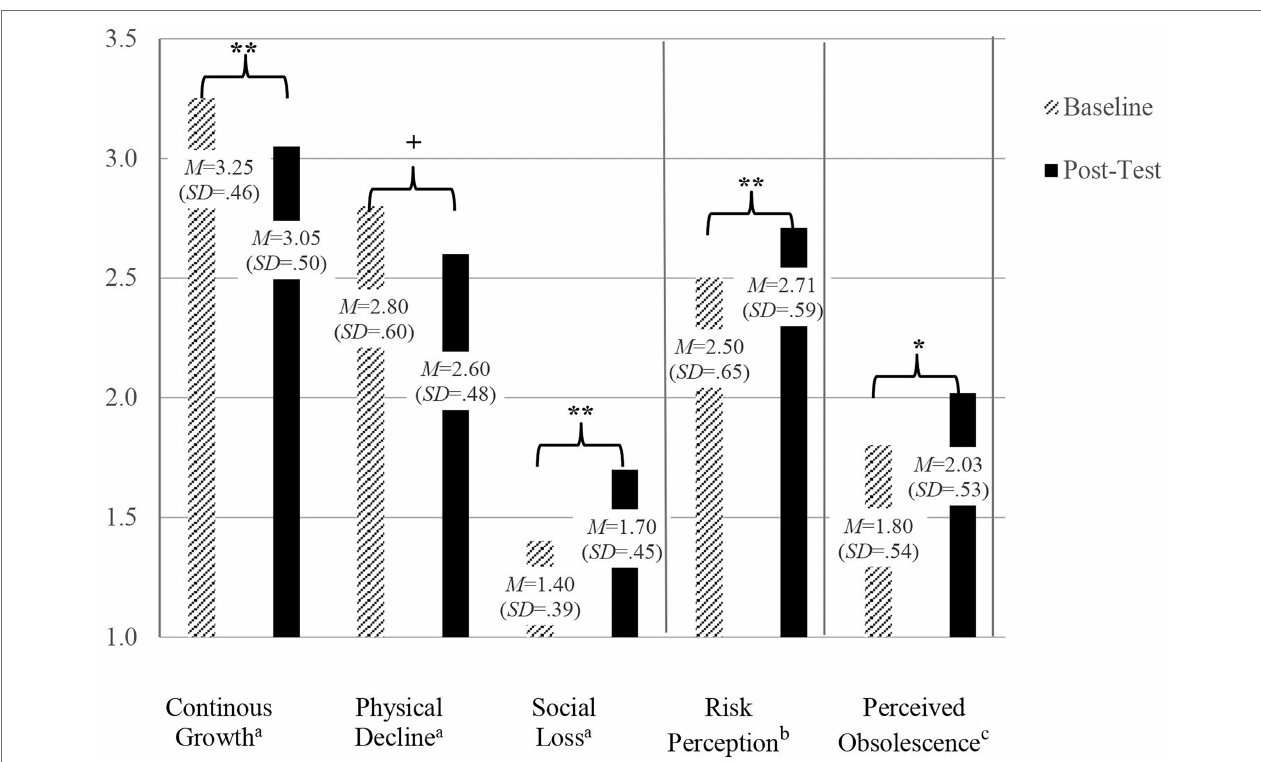
FIGURE 1 | Change in ageing-related cognitions, risk perception and obsolescence from baseline to post-assessment following the age simulation intervention. N = 40; a aging-related cognitions (AgeCog scale), 1–4, higher scores indicate stronger agreement; b 1–5, higher scores indicate higher perceived vulnerability in comparison to the same sex and age group; c 1–5; higher scores indicate higher obsolescence; + p < 0.10; * p < 0.05; ** p <